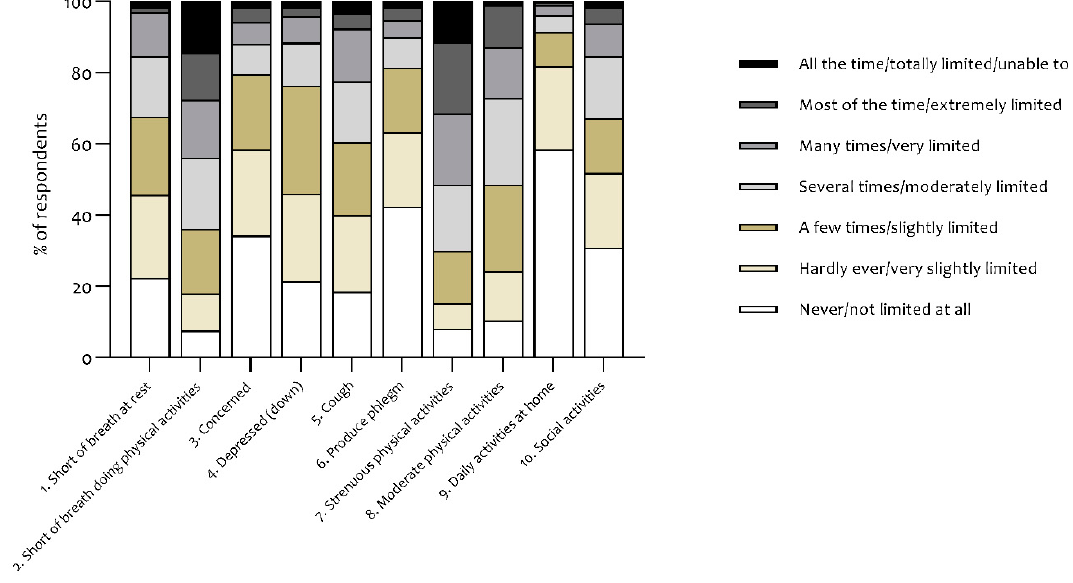
Figure 2. Distribution of responses to all of the ten CCQ items.